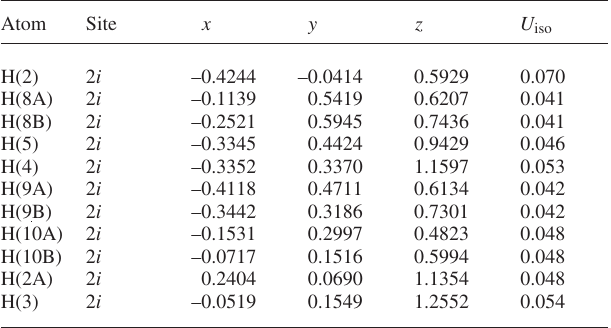
Table 2. Atomic coordinates and displacement parameters (in Å 2 )